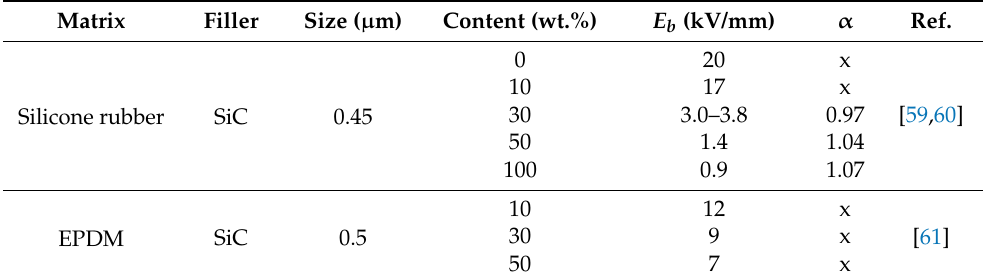
Figure 16. Relationship between conductivity and electric field for EPDM/SiC composites. © 2021 IEEE. Reprinted, with permission, from Ref. [61].